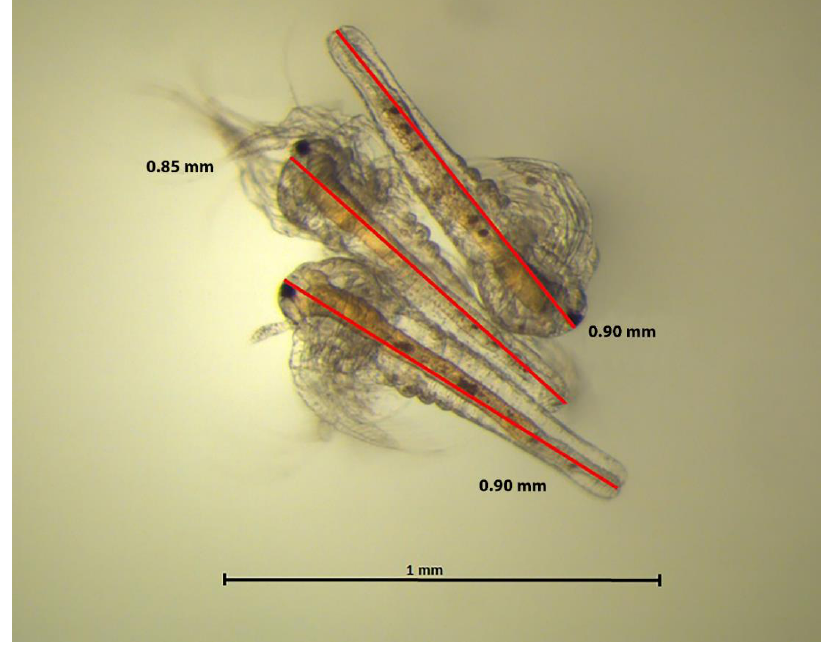
Figure 1. Body length measurement of Artemia franciscana